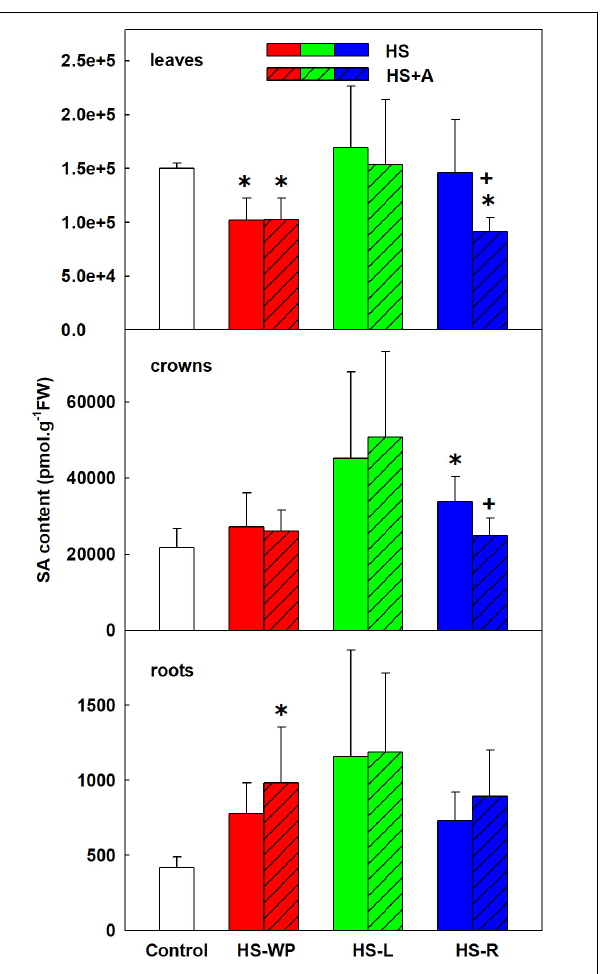
FIGURE 4 | The content of salicylic acid (SA) in leaves, crowns and roots of rice seedlings exposed to heat stress directly (HS) or after acclimation (HS + A). Heat stress was applied to whole plants (HS-WP), to leaves (HS-L), or to roots (HS-R). Data are means ± SD. One-way ANOVA with Tukey’s post hoc test ( p < 0.05, n = 6) was used to compare controls to the HS treatments. Significant differences compared to control plants are indicated by asterisks ( ∗ ) while crosses (+) indicate significant differences between HS and HS + A